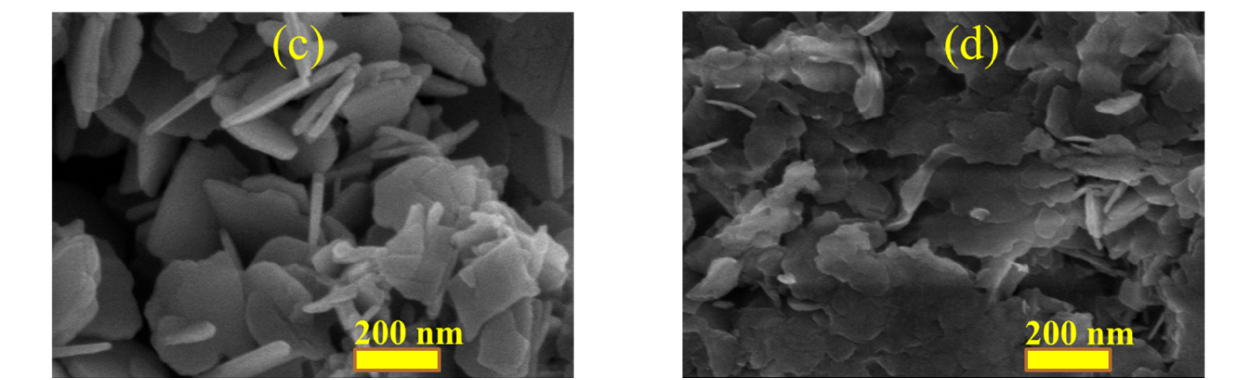
Figure 5. EDX spectra of the H ( a ), CuH–3.5 ( b ) and SEM images of the H ( c ), CuH–3.5 ( d ).